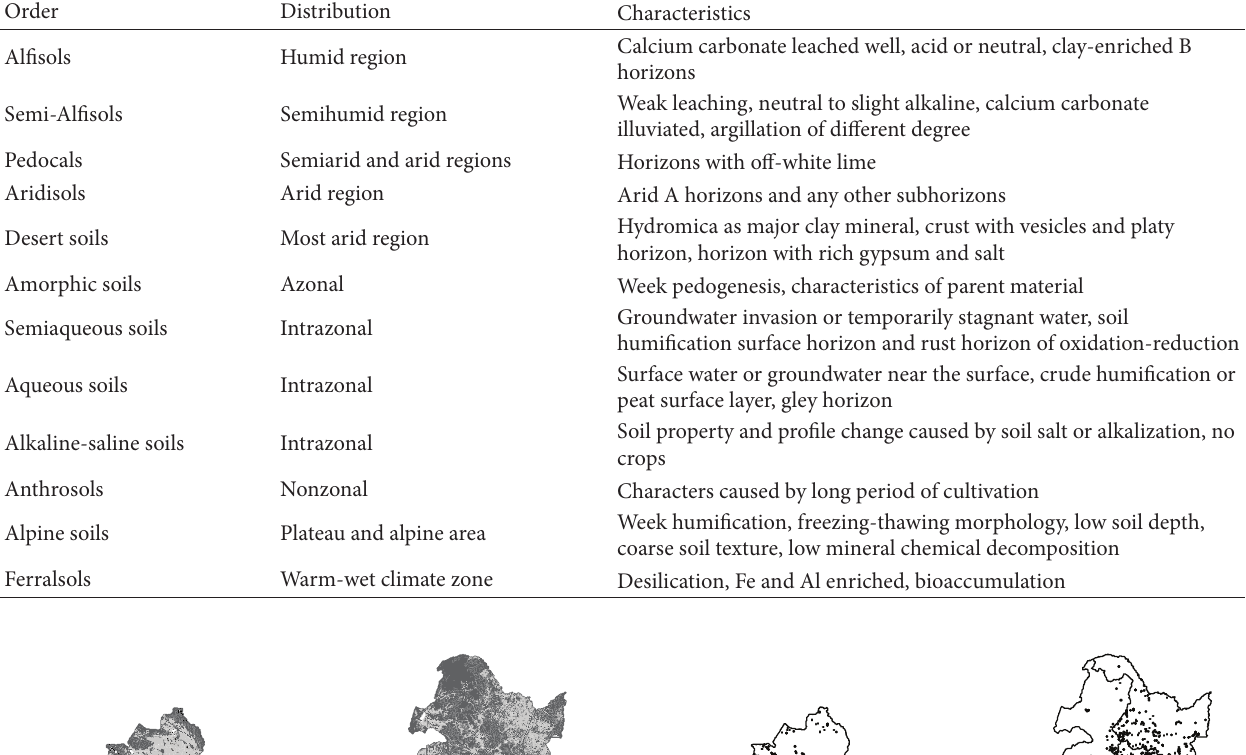
Table 2: Distribution and brief description of characteristics of the soil orders in China.